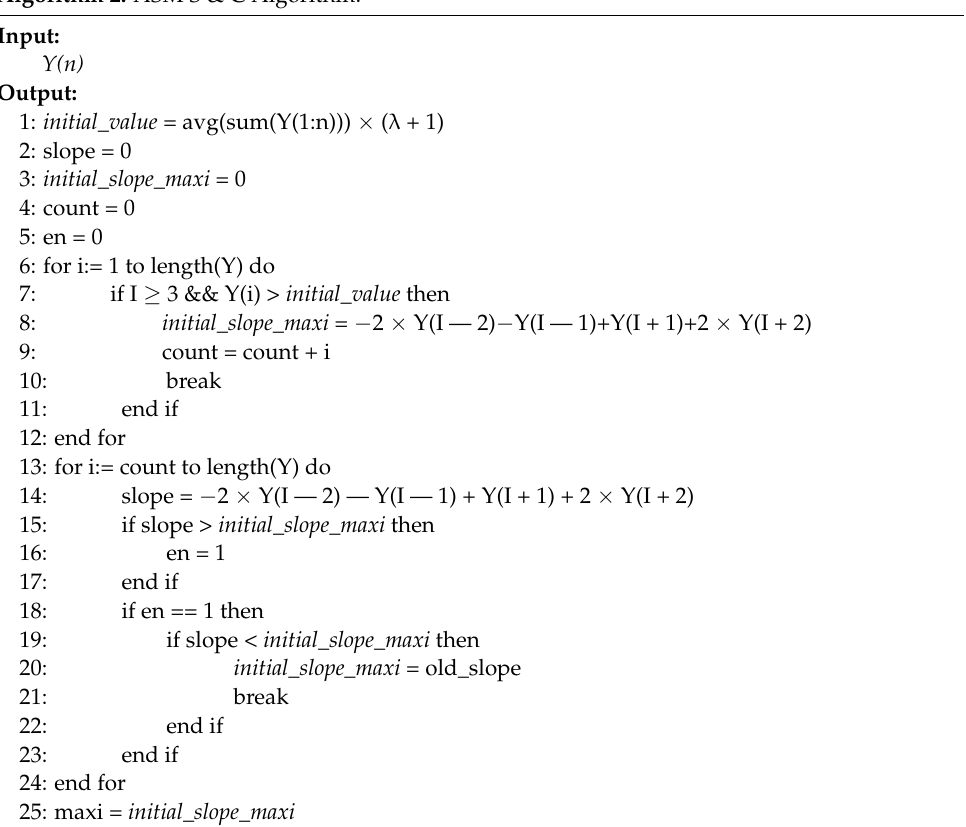
Algorithm 2: ASM S & C